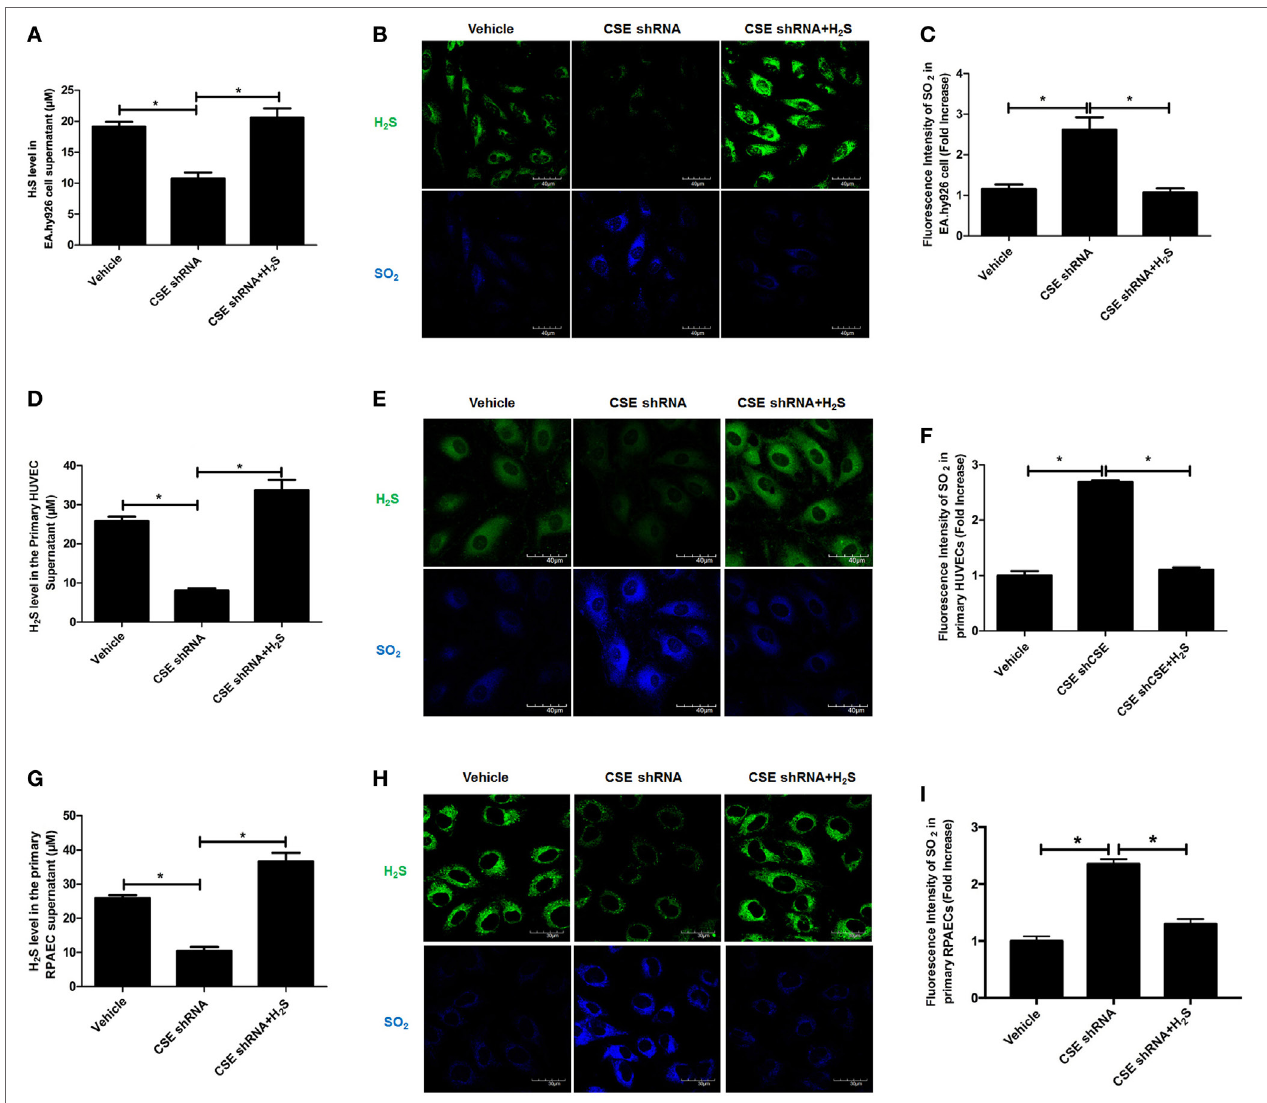
FigUre 1 | Endogenous SO 2 production was increased in cystathionine- γ -lyase (CSE) knockdown endothelial cells. The EA.hy926 cells, primary human umbilical vein endothelial cells (HUVECs), and primary rat pulmonary artery endothelial cells (RPAECs) were transfected with vehicle lentivirus or lentivirus containing CSE shRNA, and then treated with or without H 2 S donor (200 µM). (a) The H 2 S level in cell supernatant was detected by H 2 S-selective sensor in EA.hy926 cell. (B) H 2 S generation in HUVECs was detected by in situ fluorescent H 2 S probe (green color), while SO 2 generation in HUVECs was detected by in situ fluorescent SO 2 probe (blue color) in EA.hy926 cell. (c) The blue fluorescence intensity indicating endogenous SO 2 content was analyzed using Image J software in EA.hy926 cell. (D) The H 2 S level in cell supernatant was detected by H 2 S-selective sensor in primary HUVECs. (e) H 2 S generation in primary HUVECs was detected by in situ fluorescent H 2 S probe (green color), while SO 2 generation in primary HUVECs was detected by in situ fluorescent SO 2 probe (blue color). (F) The blue fluorescence intensity indicating endogenous SO 2 content was analyzed using Image J software in primary HUVECs. (g) The H 2 S level in cell supernatant was detected by H 2 S-selective sensor in primary RPAECs. (h) H 2 S generation in primary RPAECs was detected by in situ fluorescent H 2 S probe (green color), while SO 2 generation in primary RPAECs was detected by in situ fluorescent SO 2 probe (blue color). (i) The blue fluorescence intensity indicating endogenous SO 2 content was analyzed using Image J software in primary RPAECs. * P < 0.05. Data are expressed as means ± SEM, and all experiments were performed independently for at least three